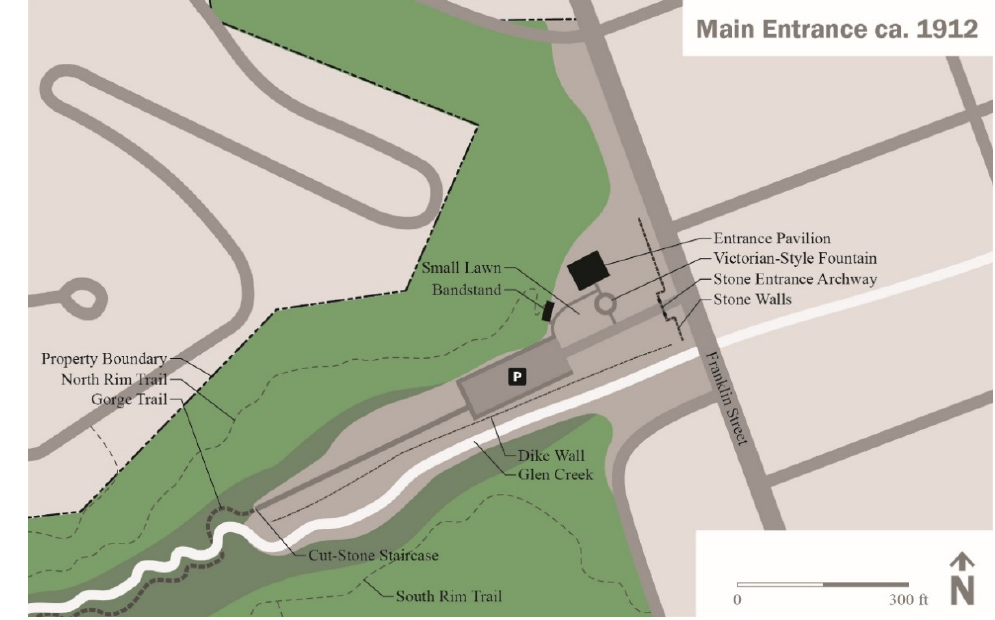
Figure 9. Plan of Main Entrance, ca. 1912, by author.